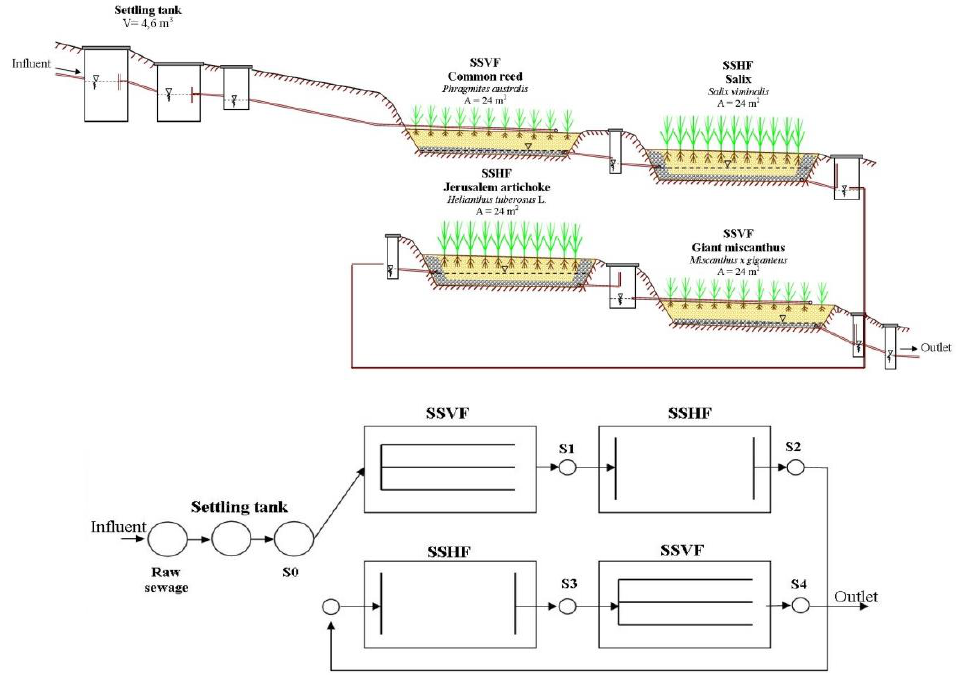
Figure 1. Technological scheme of the SSVF-SSHF-SSHF-SSVF hybrid constructed wetland with sampling points S0, S1, S2, S3 and S4. (SSVF—subsurface vertical flow, SSHF—subsurface horizontal flow).